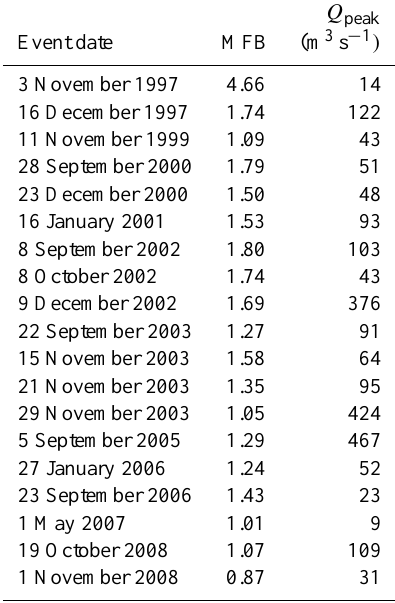
Table 1. Rainfall events occurring over the Lez catchment from 1997–2008. The date, mean field bias (MFB) and peak discharge ( Q peak ) are